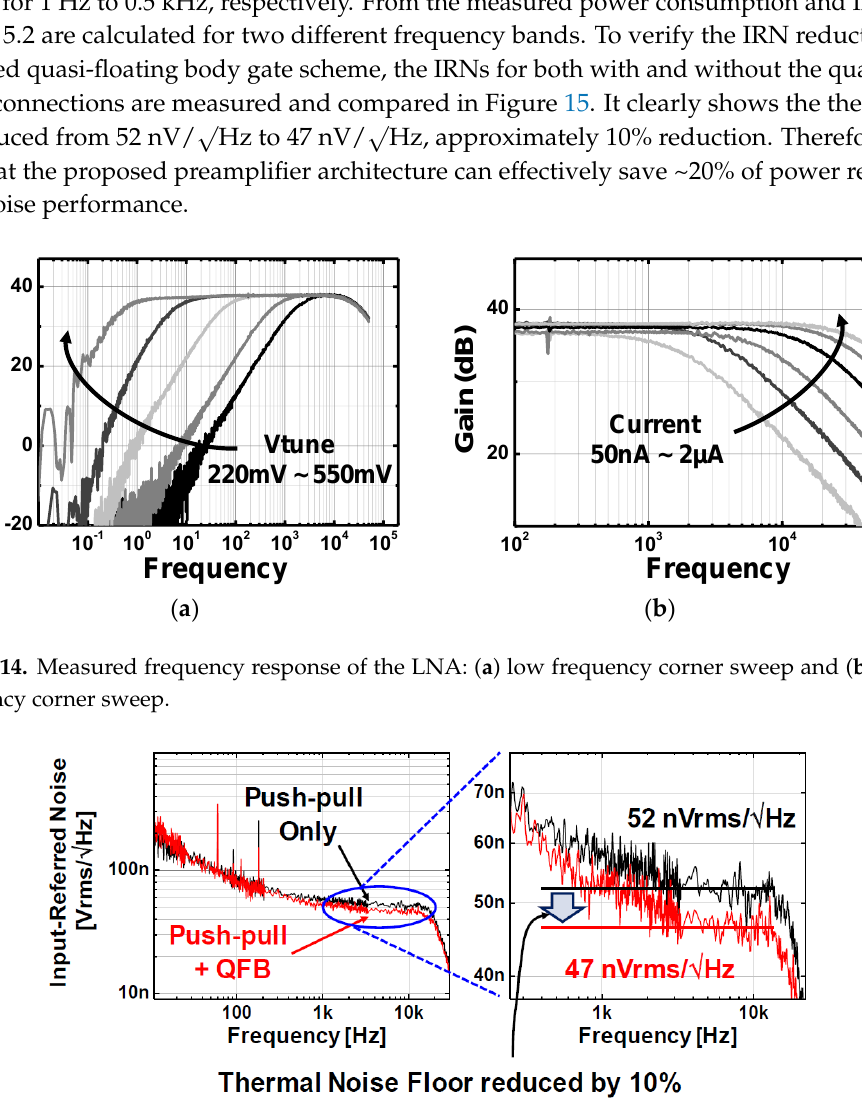
Figure 15. Measured power spectral densities of the input referred noise of the LNA with/without body input.